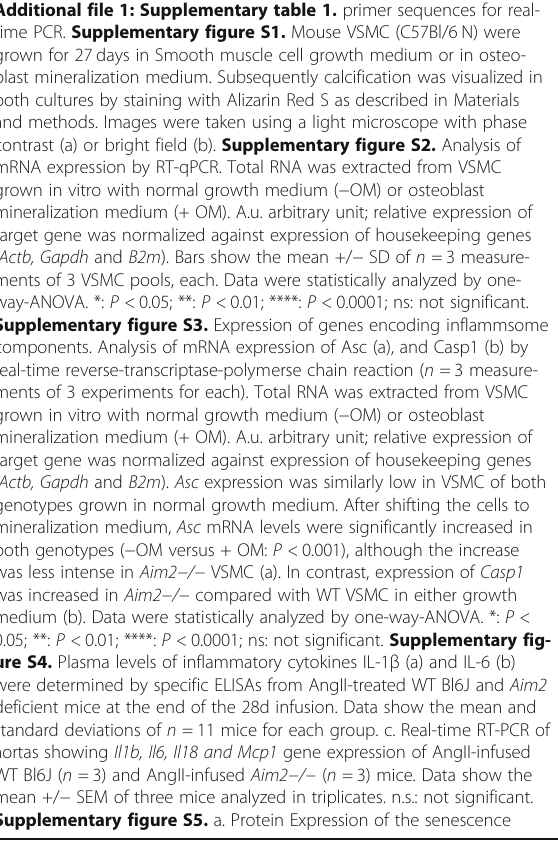
Supplementary figure S5. a. Protein Expression of the